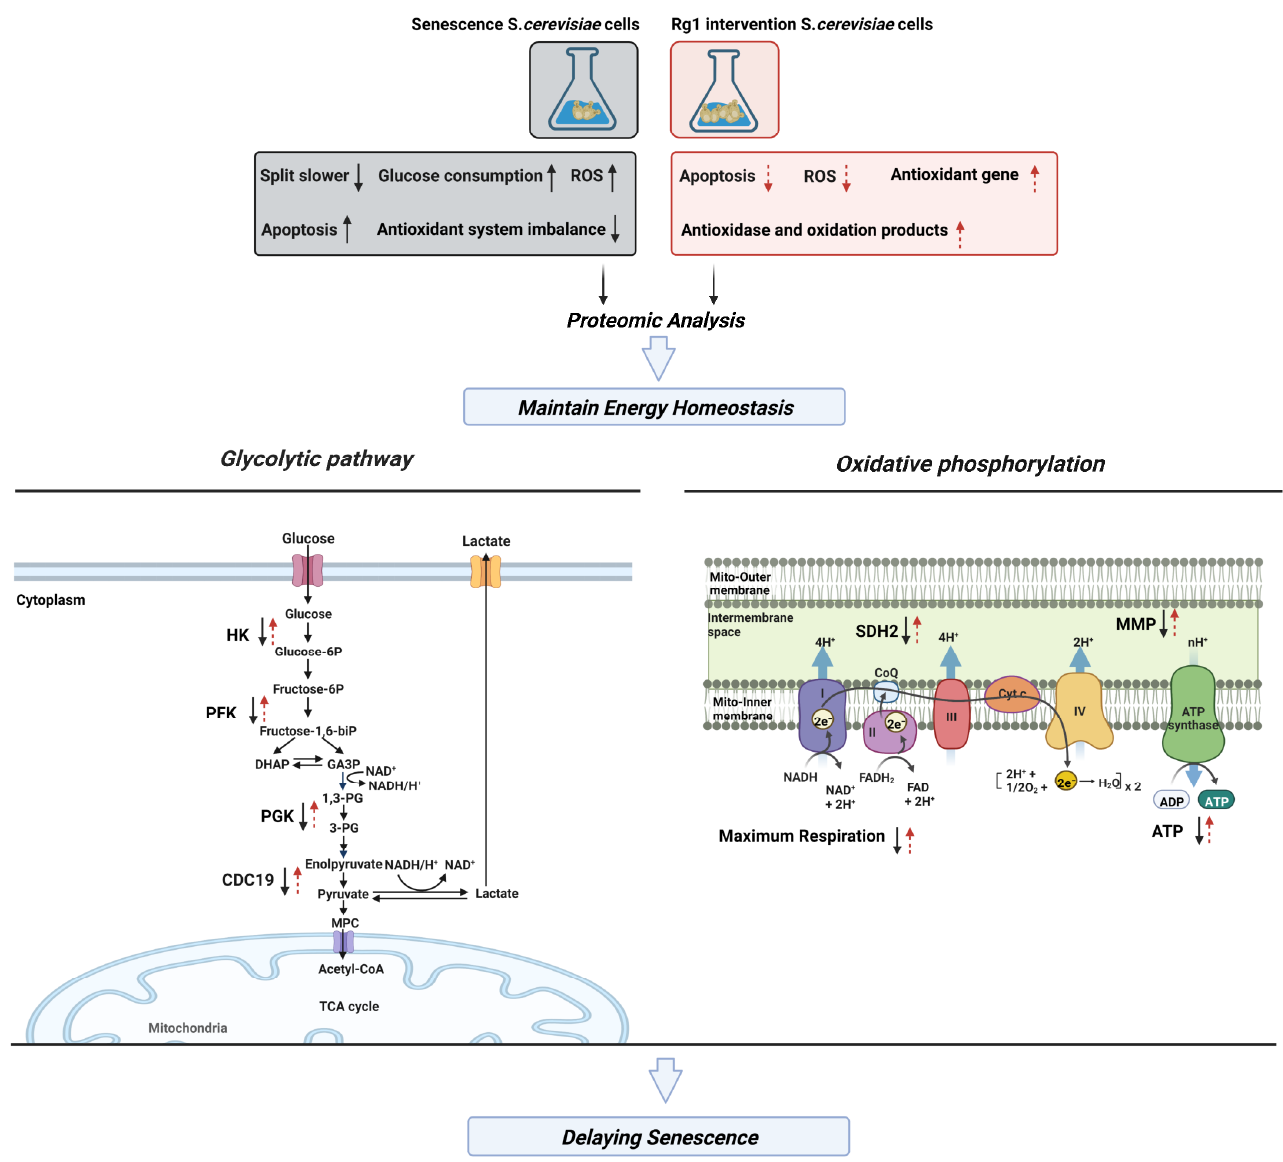
Figure 10. The effects of Rg1 on prolonging the chronological lifespan of yeast cells may be summa- rized as follows: improvement of specific parameters of mitochondrial bioenergetics, maintenance of energy metabolism homeostasis, enhancement of the activity of antioxidant enzymes, inhibition of the production of ROS, and decreased apoptosis. Rg1, ginsenoside Rg1; ROS, reactive oxygen species; HK, hexokinase; PFK, phosphofructokinase; PGK, phosphoglycerate kinase; CDC19, homologue of pyruvate kinase; ATP, adenosine triphosphate; SDH2, succinate dehydrogenase iron–sulfur protein subunit; MMP, mitochondrial membrane potential.